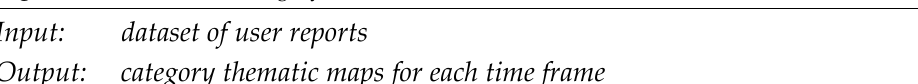
Algorithm 1 : GIS-based category classification.